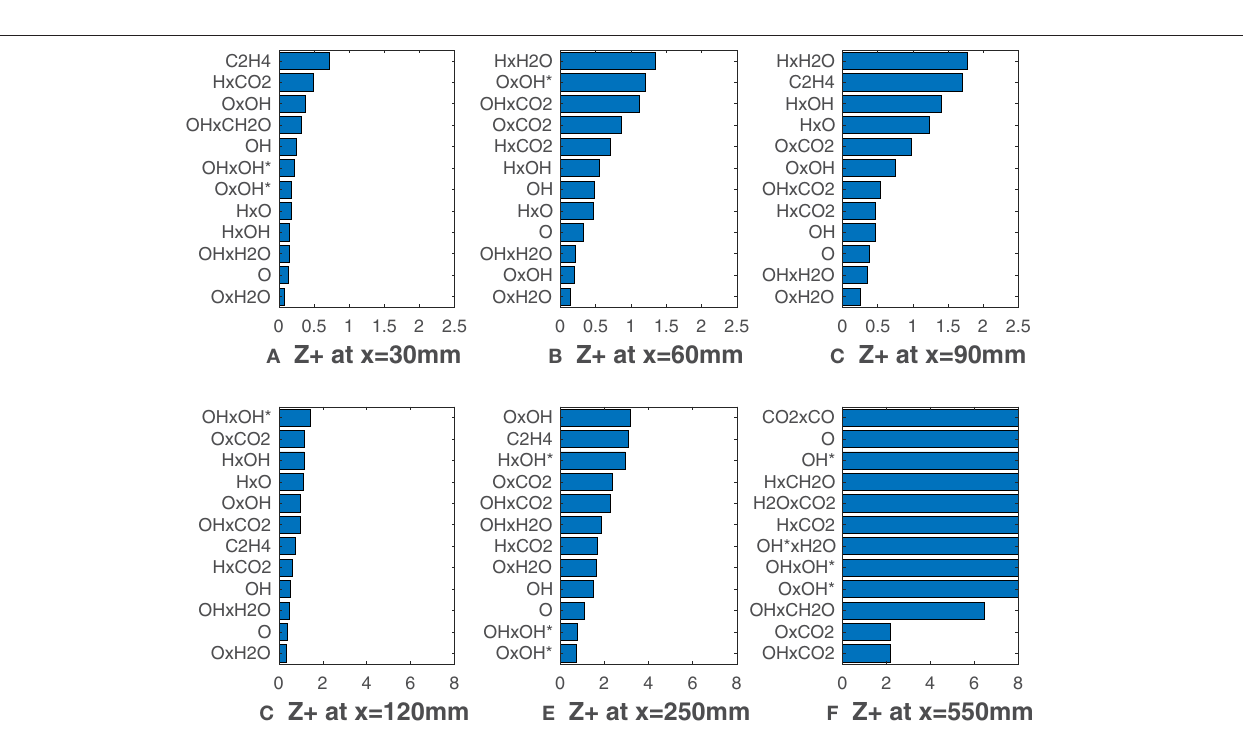
Frontiers in Mechanical Engineering |